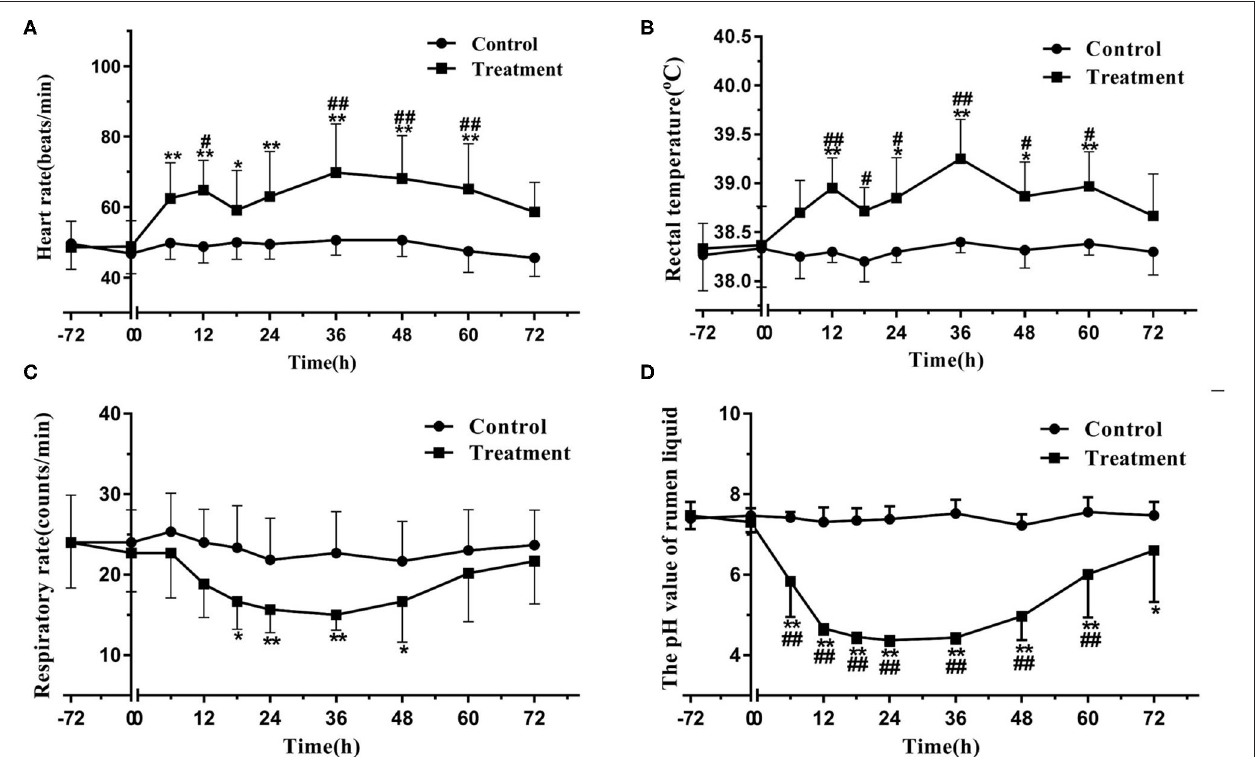
FIGURE 1 | Changes in heart rate (A) , rectal temperature (B) , respiratory rate (C) , and pH value of rumen liquid (D) in the heifers with oligofructose-induced laminitis. Within a time point, the values of the treatment group significantly differed from those of the control group, indicated as # P < 0.05 and ## P < 0.01; within the treatment group, the values of distinct time points significantly differed from the baseline value (time 0), indicated as * P < 0.05 and ** P <